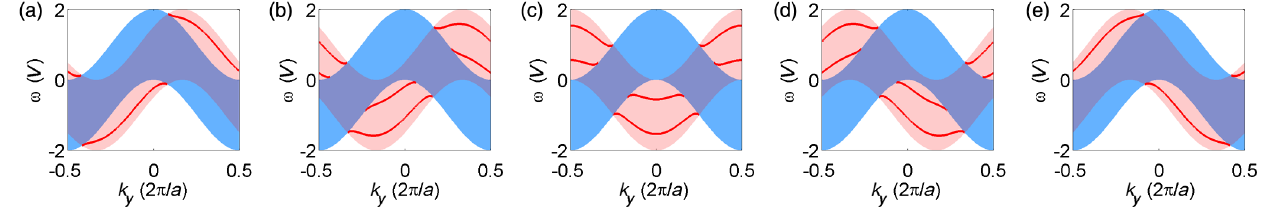
FIG. 5. Guided mode dispersions obtained by solving the Hamiltonian in Eq. (6) with a core region width d ¼ 2 a ( N ¼ 2 ) and a a ¼ ½ 1 = 3 ; 2 = 3 ; 1 ; 4 = 3 ; 5 = 3 (cid:1) π (a) – (e). cladding region width of 10 a on each side for ϕ ¼ A y